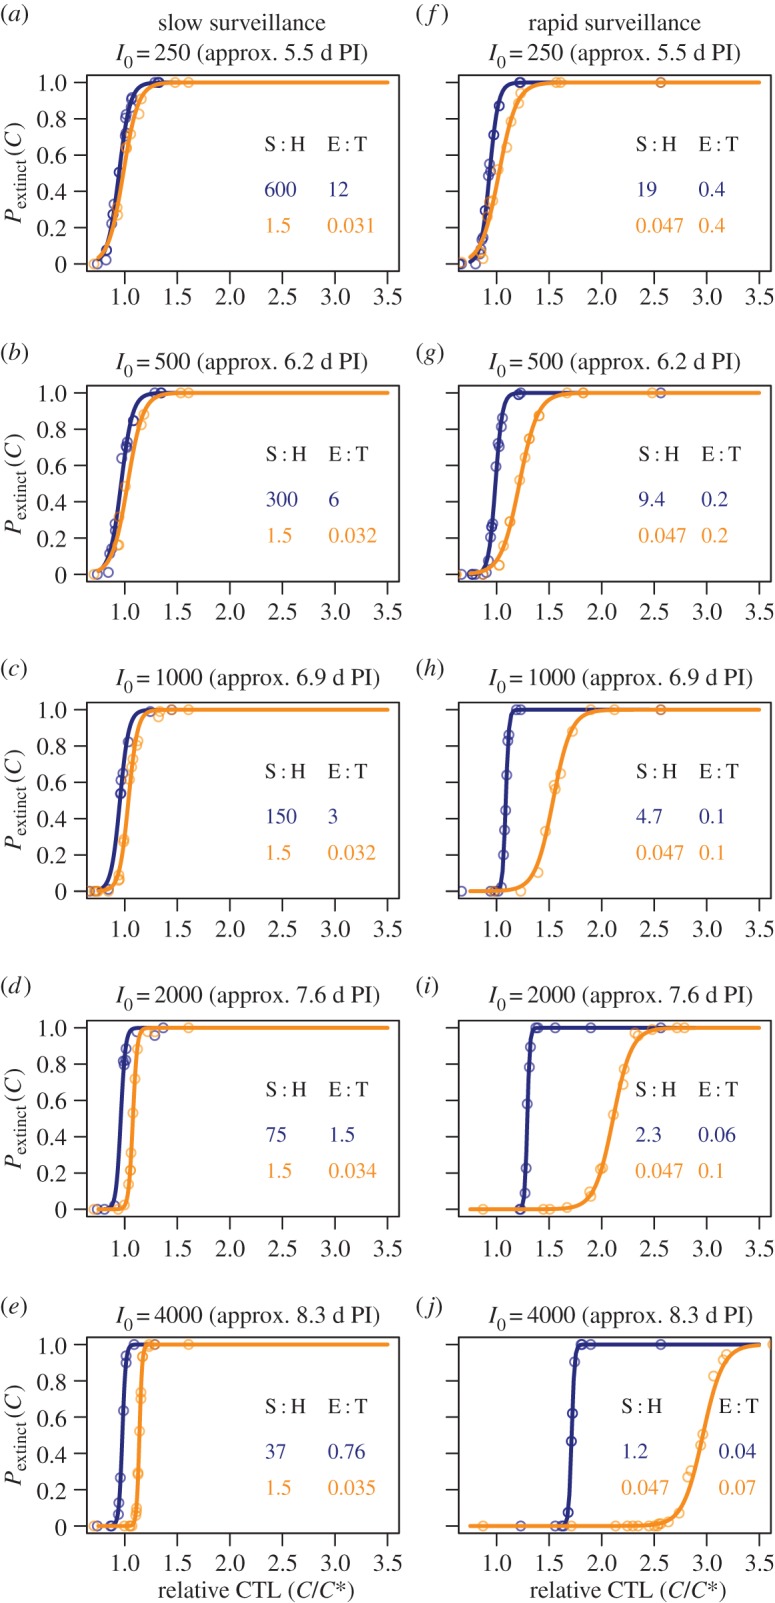
Probabilities of extinction as a function of CTL density in units of the mass-action estimate C*= r/k. (a–e) Slow CTL surveillance such that S : H > 1 even within packed clusters of infected cells; (f–j) more rapid CTL migration, such that S : H < 1 within clusters. Blue curves, diffuse infections; orange curves, clustered infections. S : H ratios are approximate and calculated as follows: for diffuse infections, S is the expected time for a CTL to locate its first target following the appearance of CTL when infected cell numbers have reached I0, S ≃ N/kI0, where I0/N is the proportion of all susceptible cells infected. For clustered infections, the search time is quoted as the time taken to move between adjacent cells within a packed cluster of infected cells, and so is a strong lower bound on the average search time. E : T ratios are quoted as the ratio of total effectors to total targets at the critical CTL density C*. PI, post-infection.